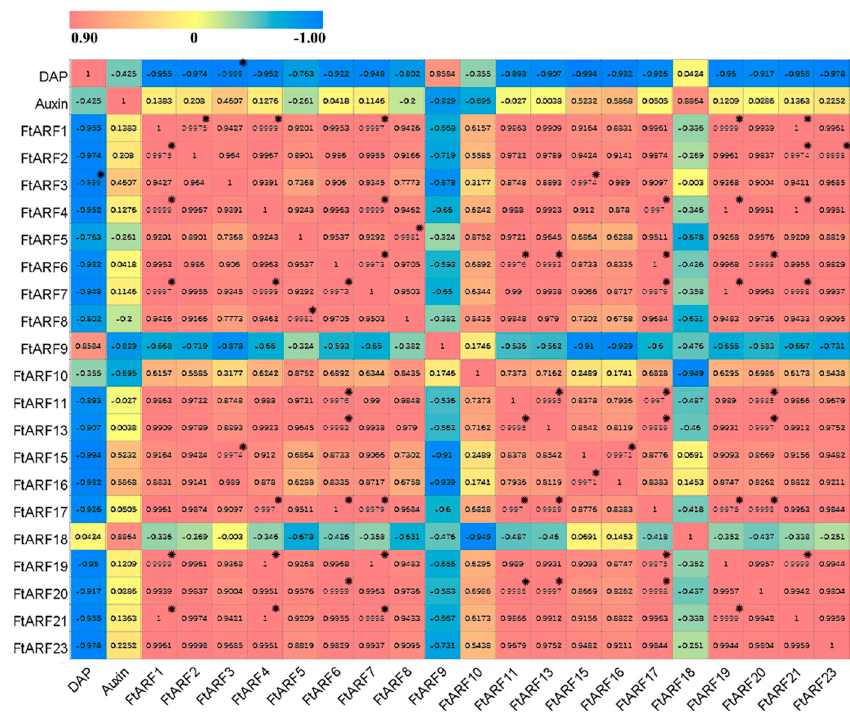
Figure 7. The correlation between the gene expression of FtARFs and auxin during fruit development. Red: positively correlated; Blue: negatively correlated. * indicates significant correlation at 0.05 levels.